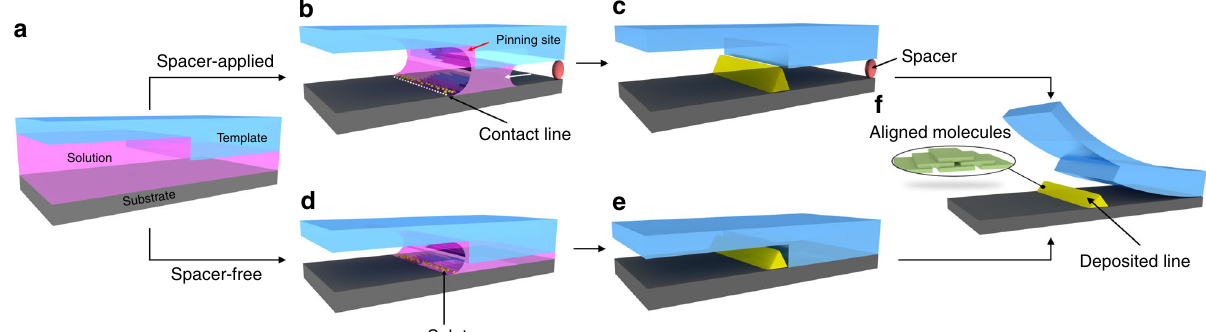
Fig. 1 Schematic illustration of the pattern-formation process. The solution is patterned and pinned by the groove corners during drying. Spacer-applied ( a → b → c ) and spacer-free ( a → d → e ) con fi gurations can be used to fabricate fi ne structure through solute transfer to the pinned contact line via capillary fl ow. For convenience, only half of one ridge and groove is drawn. The molecular alignment and backbone packing with face-on con fi guration in the generated lines are presented in